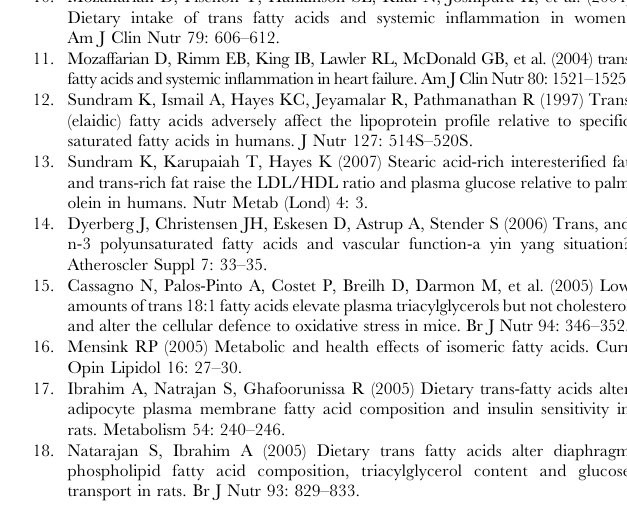
Table S1 OASMa: Overt Aggression Scale Modified – aggres- sion subscale. LHA: Life History of Aggression. CTS: Conflict Tactics Scale. * P , 0.0001 for all correlations. Table S2 OASMa: Overt Aggression Scale Modified - aggres- sion subscale. LHA: Life History of Aggression. CTS: Conflict Tactics Scale. Power was greater for men, who represented 68% of the sample (about twice as many men as women). * Significant change in aggression shown in bold (P ,